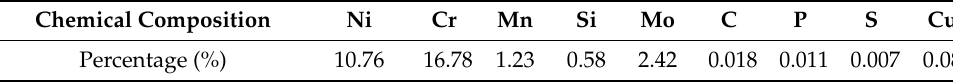
Table 1. Chemical composition of the 316L stainless steel.